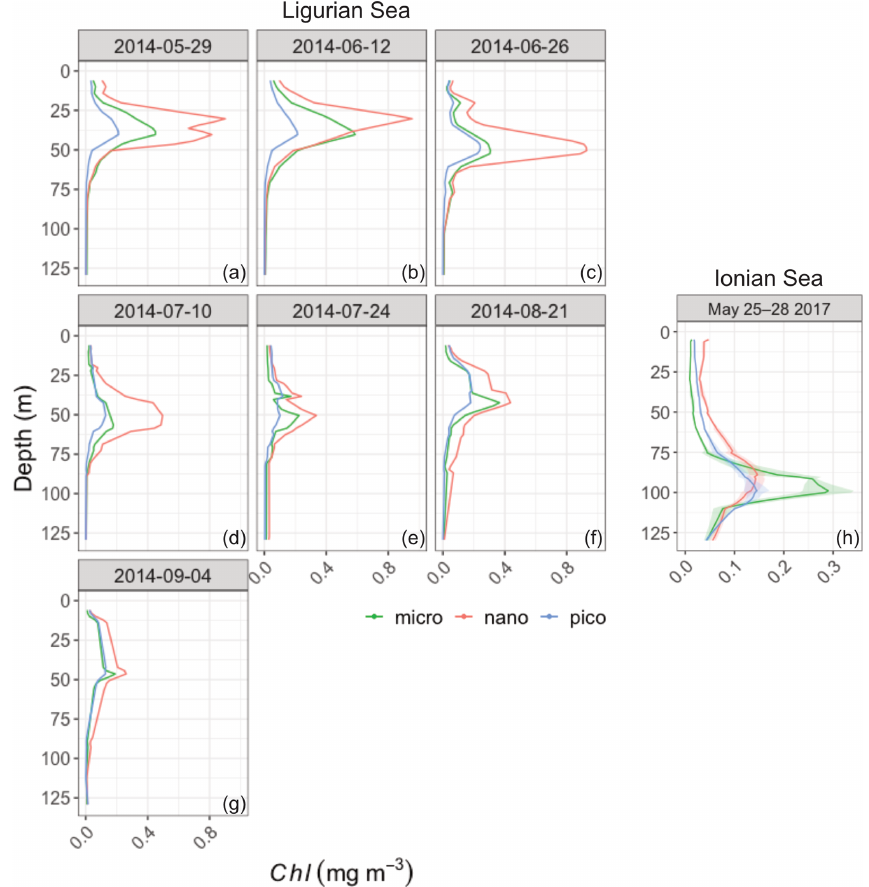
Figure B1. Vertical distribution of the chlorophyll a concentration of the micro- (green), nano- (red) and picophytoplankton (blue) derived from HPLC pigment determinations in the Ligurian Sea (BOUSSOLE site; a–h ) and the Ionian Sea (PEACETIME cruise; i ). For the Ionian Sea the solid line shows the mean value, and the shaded area shows the standard deviation, calculated over a 4d window (25–28 May 2017). Please note that the date formats in this figure are year-month-day and month day